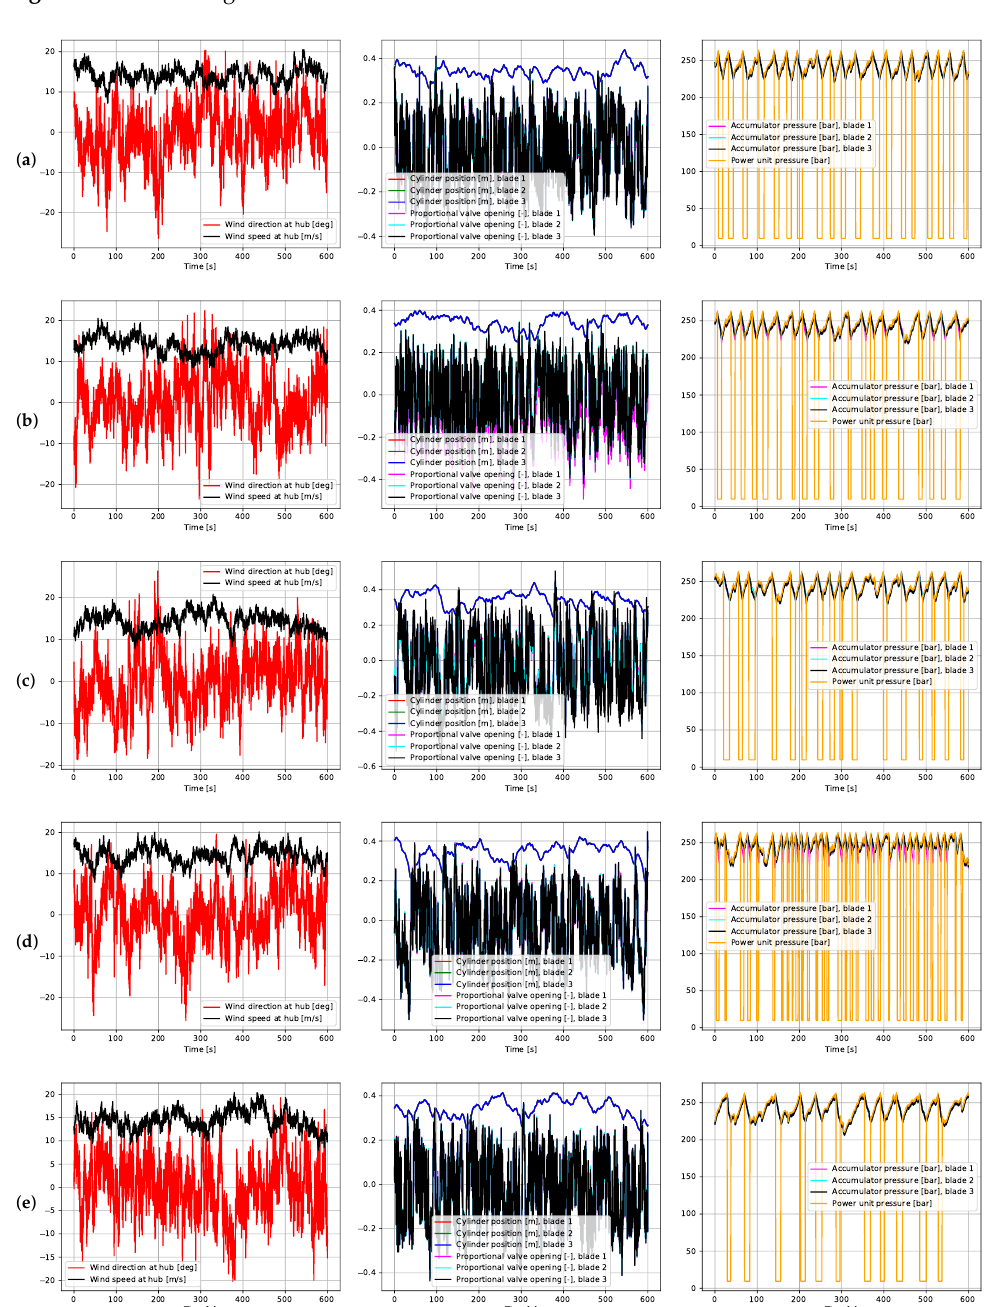
Figure 10. Results of some 10 minute simulations with (a) nominal conditions, (b) a piston seal leak at blade 1, (c) extra friction at blade 3, (d) 50% loss of nitrogen at blade 1 and (e) 6 L/min loss of pump flow.